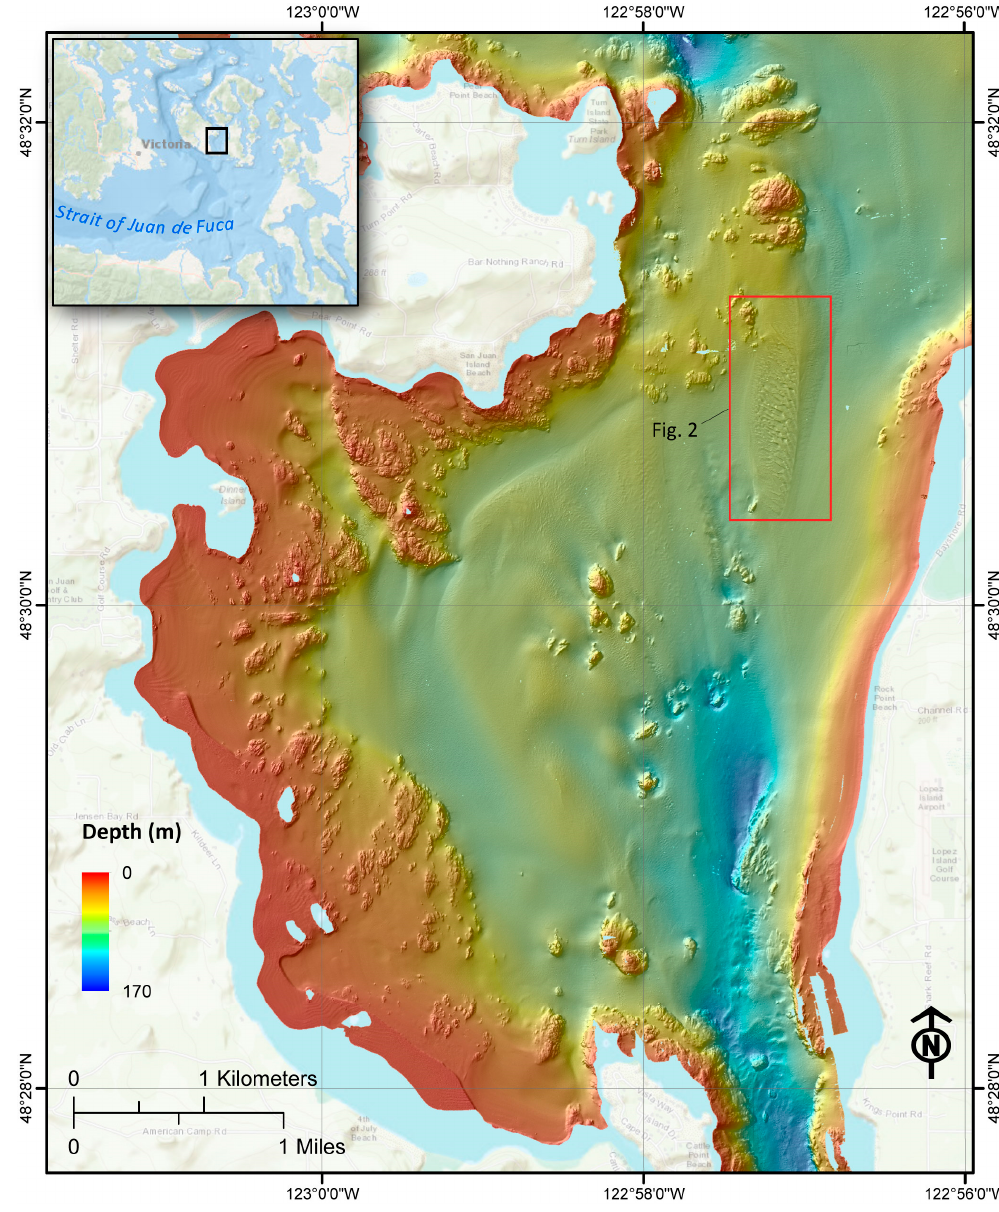
Figure 1. Multibeam echosounder bathymetric map showing the location of the San Juan Channel sediment wave field within the San Juan Archipelago of the Pacific NW, Washington State, USA. The bedform investigated for this study is prominently displayed near the top of the bathymetric image. The Pacific sand lance (PSL) is found along the coastal North Pacific Ocean from northwestern California to northern Japan, and is one of six species in the genus Ammodytes [1,2]. Although PSL are a key component in the marine food web, little is known of this species’ sub-tidal habitats. Their burrowing behavior, recruitment rates and conditions, relative abundance and distribution, population structure, local spawning habits, and spawning and burial substrates have been studied [1,3,4]. Previous work on PSL biology and habitat associations has focused on the near-shore and shallow sub-tidal areas [5–7]. It has recently been shown that predominant and important habitats exist in deeper sub-tidal and deep-water environments [8].